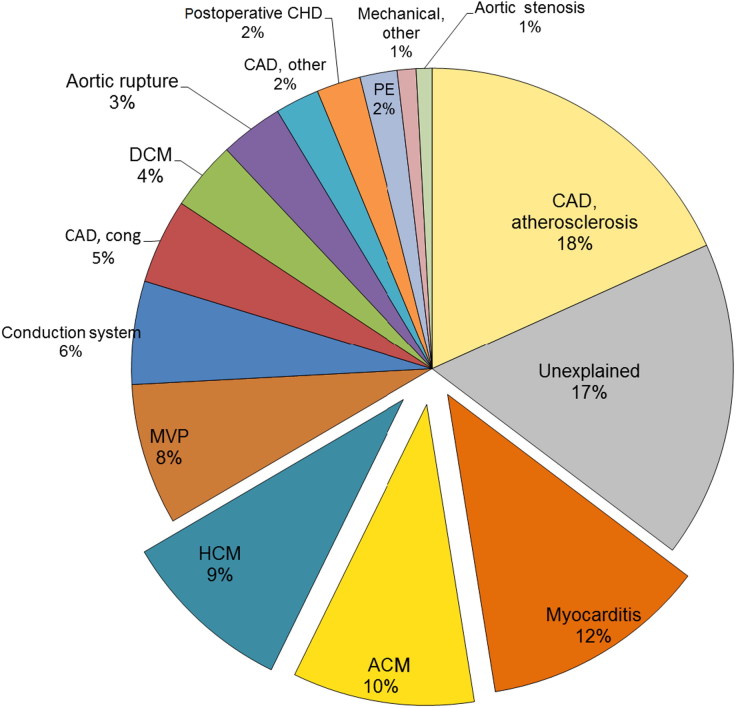
Causes of sudden death in Veneto Region Northeast Italy, time interval 1980–2013. CAD: coronary artery disease; ACM: arrhythmogenic cardiomyopathy; HCM: hypertrophic cardiomyopathy; MVP: mitral valve prolapse; cong: congenital anomalies of the coronary arteries; DCM: dilated cardiomyopathy; CHD: congenital heart disease; PE: pulmonary embolism.